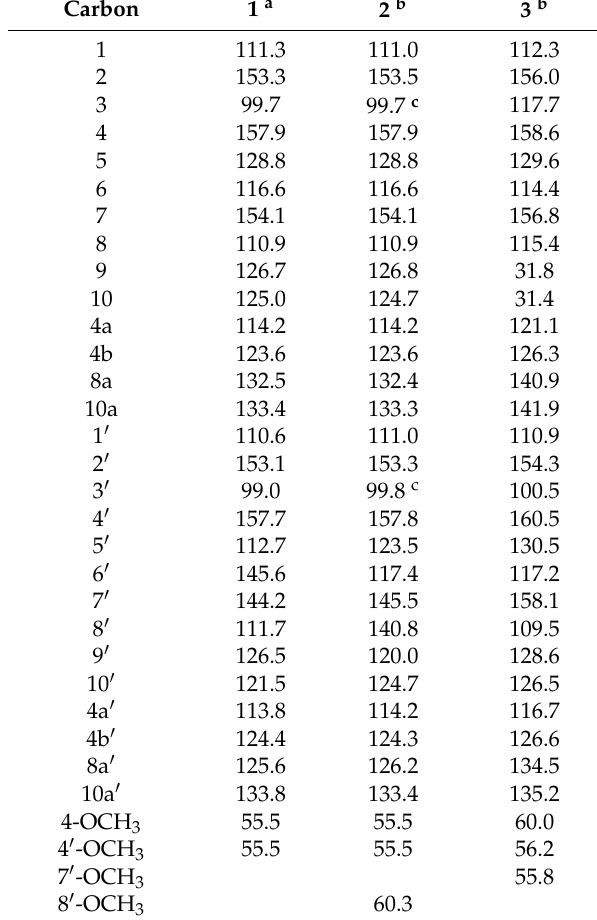
Table 2. 13 C-NMR Data of compounds 1 – 3